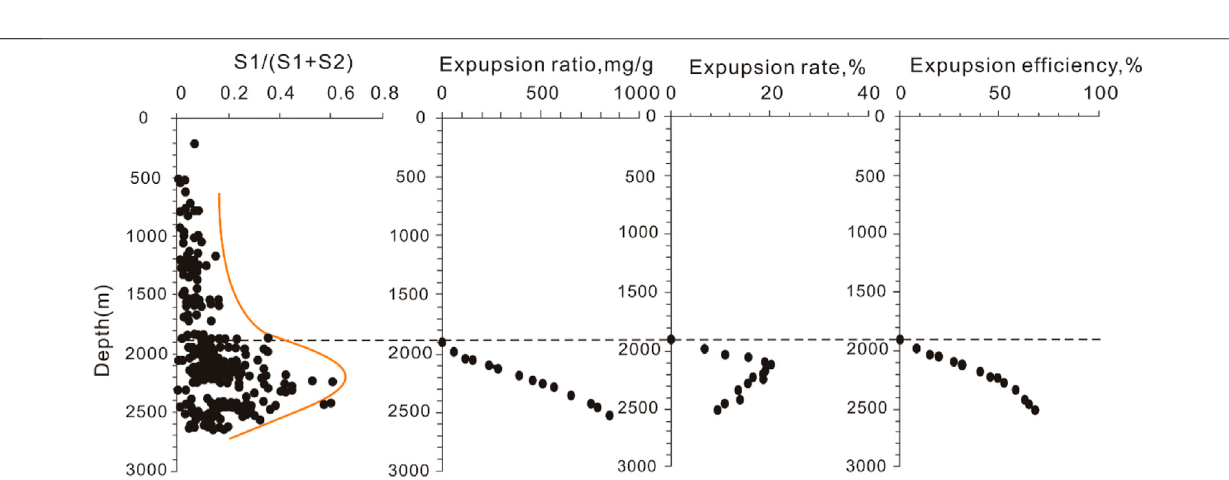
Frontiers in Earth Science |